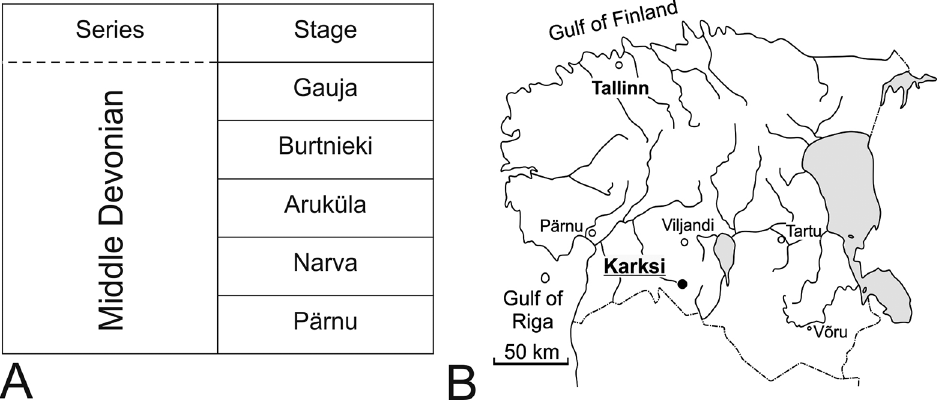
Fig. 1. A , fragment of the Middle Devonian stratigraphical chart of Estonia, showing the position of the Burtnieki Regional Stage. B , geographical location of the Karksi